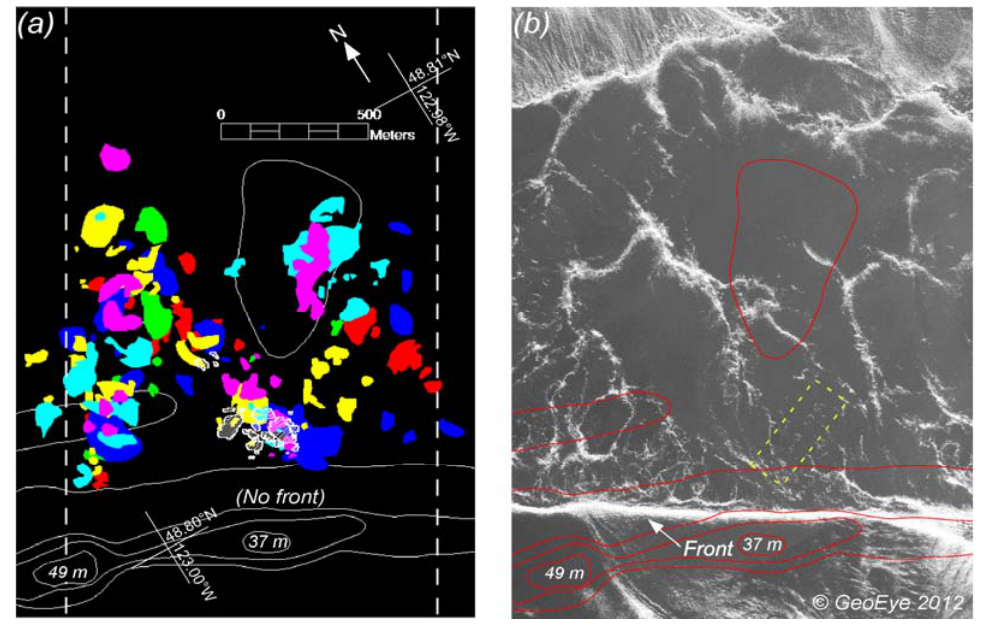
Figure 11. ( a ) Boil census, using 1,525-m-altitude airborne data collected on 18 May 2009: red (0335 UTC), green (0344 UTC), blue (0351 UTC), yellow (0359 UTC), cyan (0409 UTC), and magenta (0416 UTC). Area between the dashed vertical lines is common to each pass. Boils from 23 May (extracted from Figure 5(d)) are added as the white crosshatched areas; ( b ) GeoEye panchromatic imagery (14 July 2012) over the same